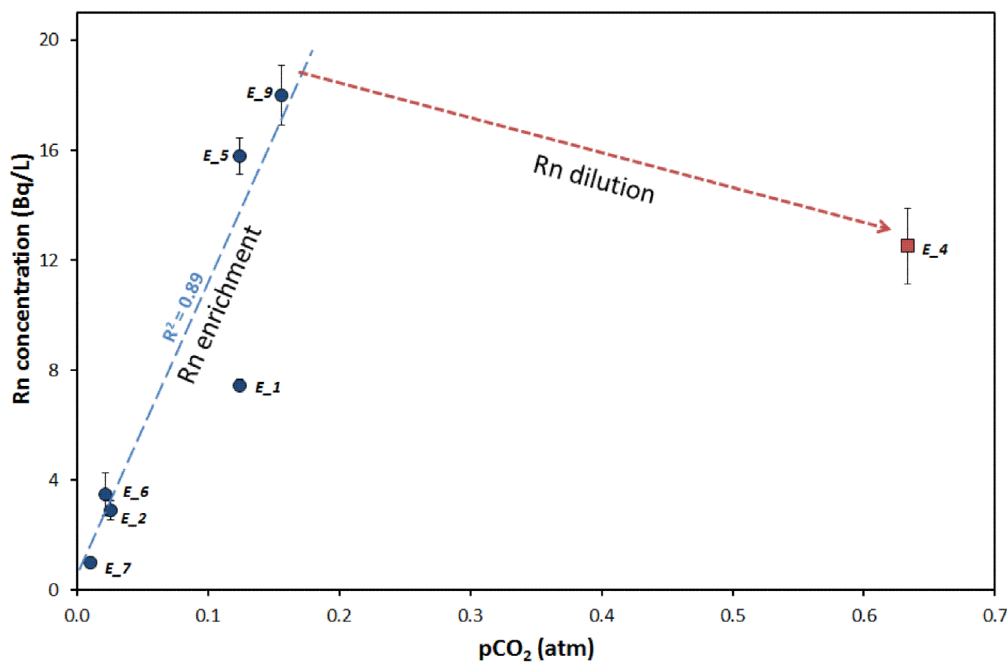
Figure 5. Correlation between radon activity in solution and pCO mechanism of radon enrichment and dilution produced by increasing input of volcanic CO value of the R 2 correlation coefficient for the best-fit line relevant to samples affected by radon enrichment is also